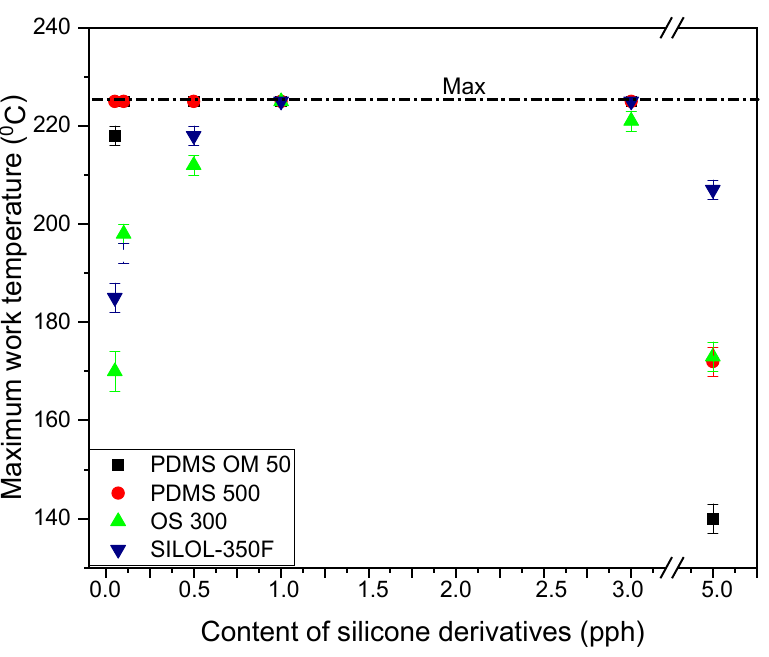
Figure 4. The maximum work temperature of silicone pressure sensitive adhesives with different silicone derivatives addition.